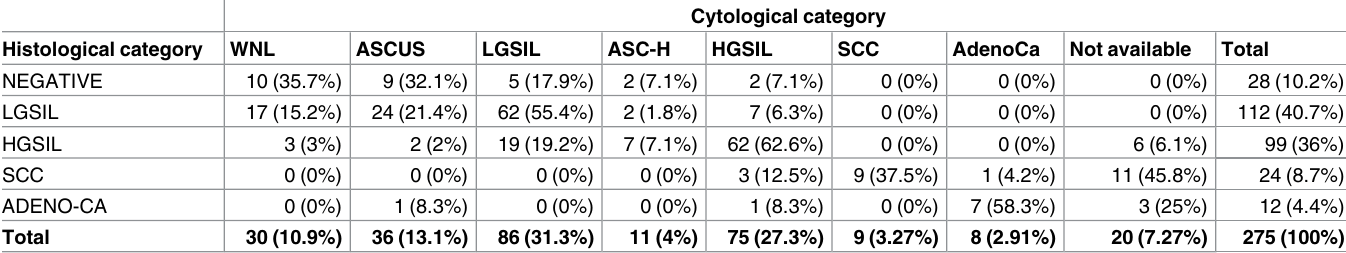
Cytological category